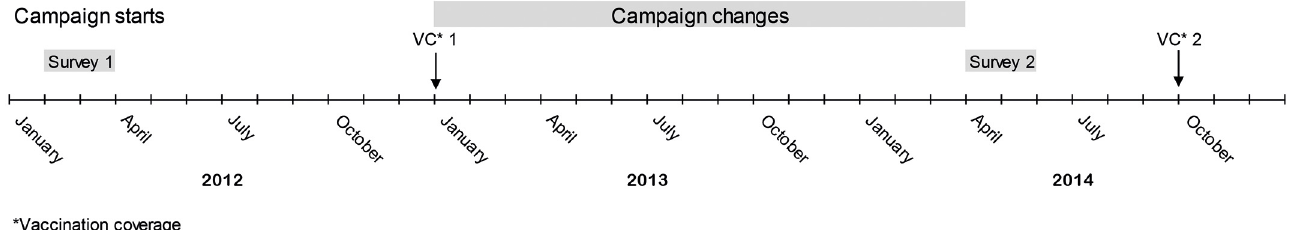
Fig 1. Timeline. Schematic description of the activities carried out during the study period.